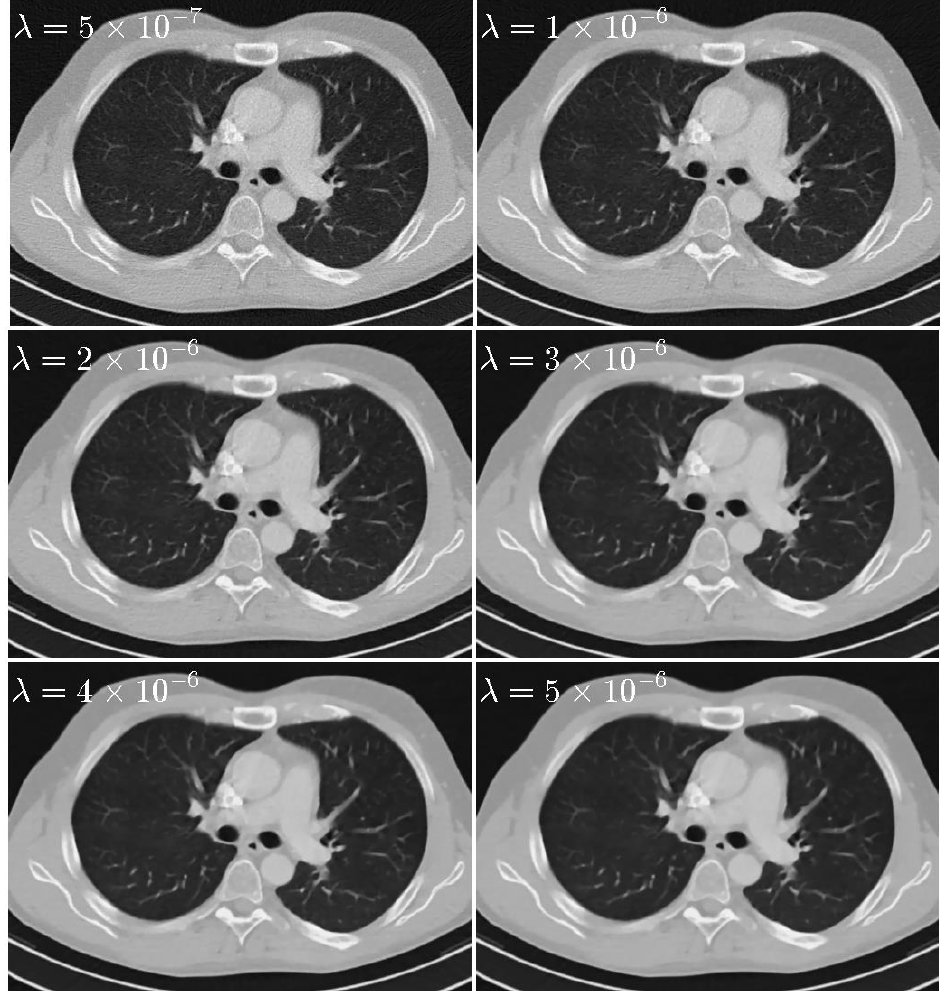
Figure 6. Thorax images reconstructed by the SIR-STV 1 method with respect to different λ . The display window is [–1000, 667] HU.